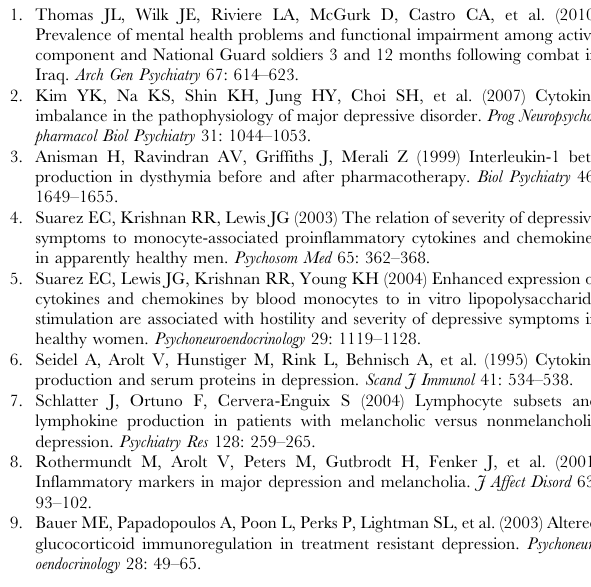
Table S1 Fit and measurement parameters of the subsequent exploratory structural equation modeling